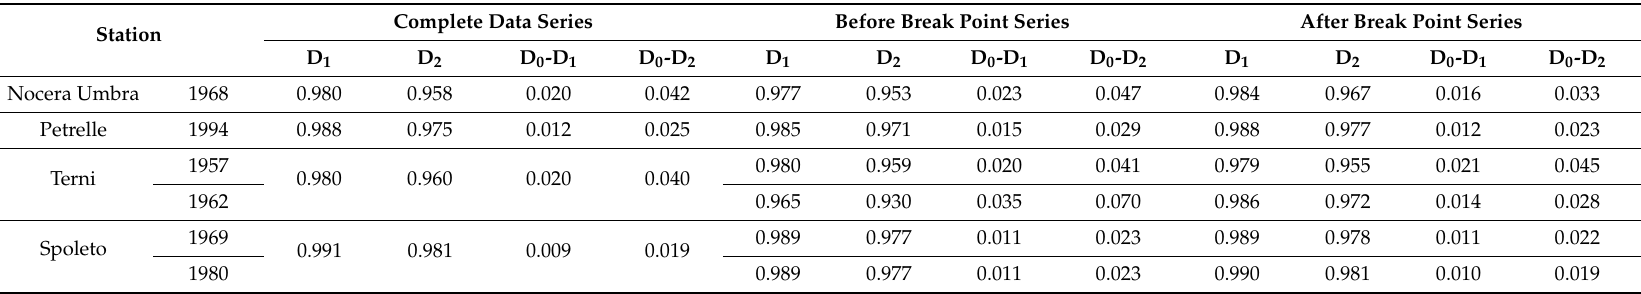
Table 5. Main results obtained for the R é nji spectrum of the extreme rainfall data series for which break points were detected by the statistical tests. Station